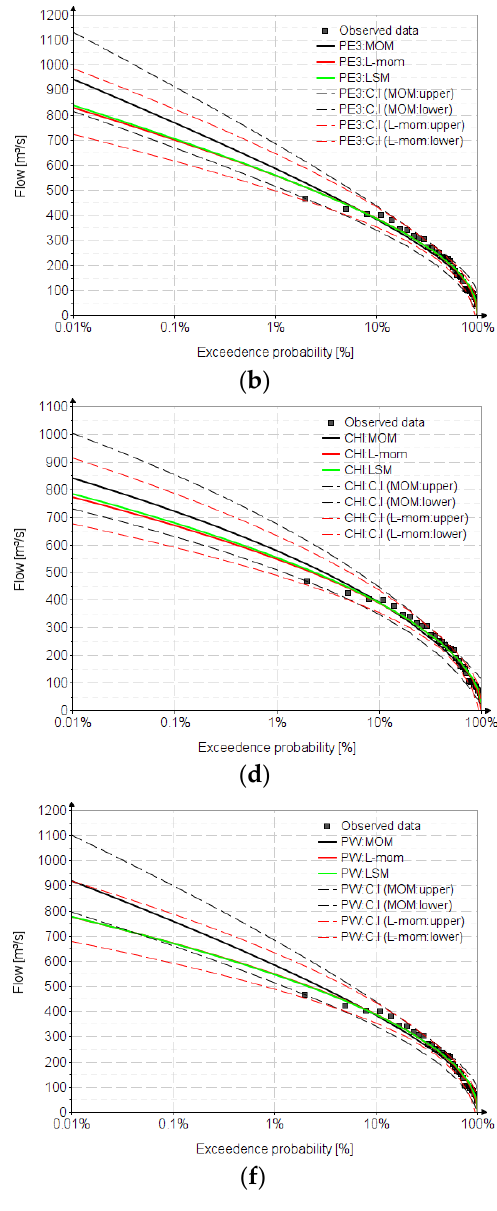
Figure 6. Fitting distributions. ( a ) Kritsky–Menkel; ( b ) Pearson III; ( c ) Wilson–Hilferty; ( d ) chi; ( e ) inverse chi; ( f ) pseudo-Weibull. Table 8. Estimated parameter